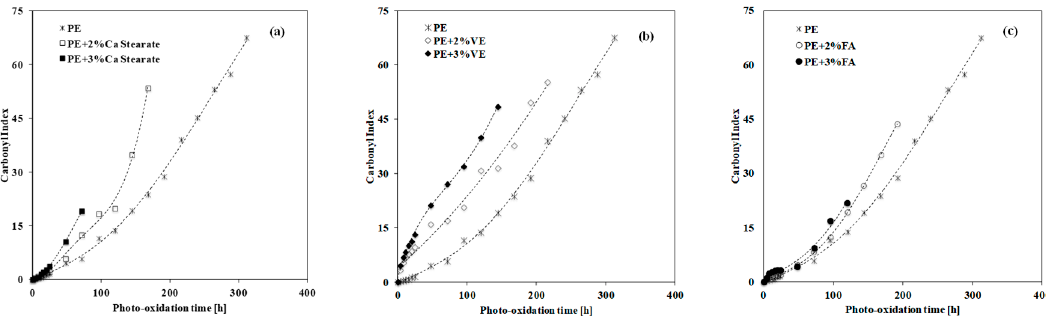
Figure 4. Carbonyl Index of neat PE and PE containing different compounds as a function of the photo-oxidation time. ( a ) Ca stearate; ( b ) Vitamin E; ( c ) Ferulic Acid. photo-oxidation time. ( a ) Ca stearate; ( b ) Vitamin E; ( c ) Ferulic Acid.